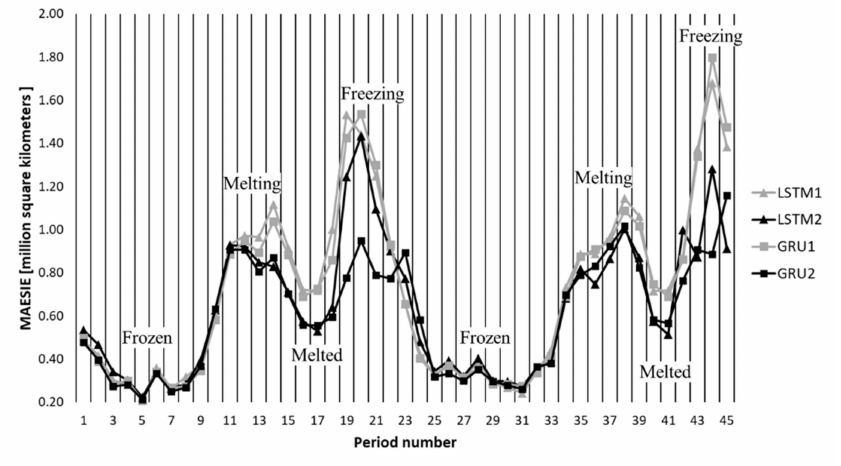
Figure 8. Mean absolute error in sea ice extent (MAESIE) in the test periods.